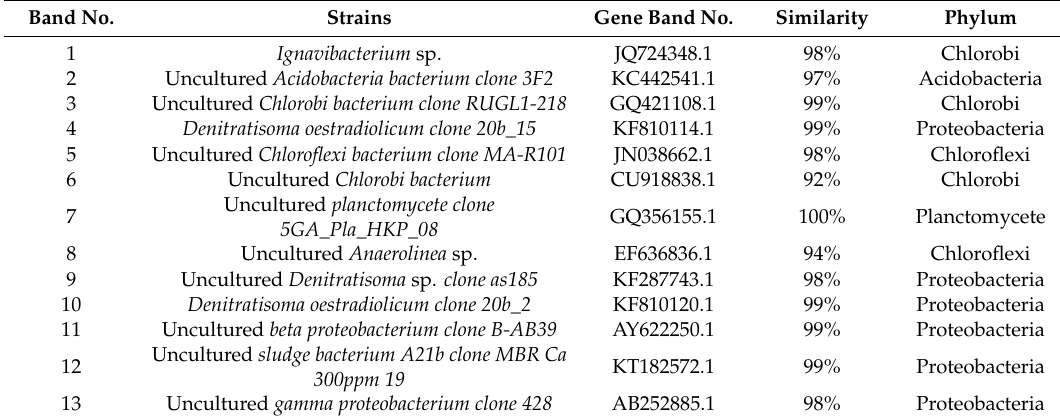
Table 4. Homology search results for 16S rRNA gene sequences of the main bacterial members in the anammox sludge